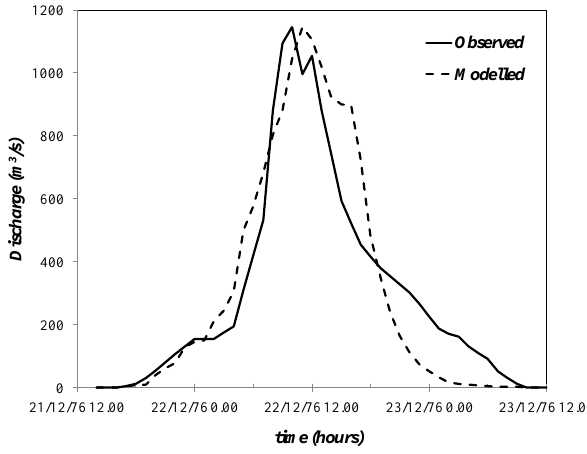
Figure 10. Comparison between observed and modelled hydro- graphs for the event of 21 December 1976. Table 8. Marginal distribution parameters and goodness of fit re- sults for flood peaks ( Q max ).